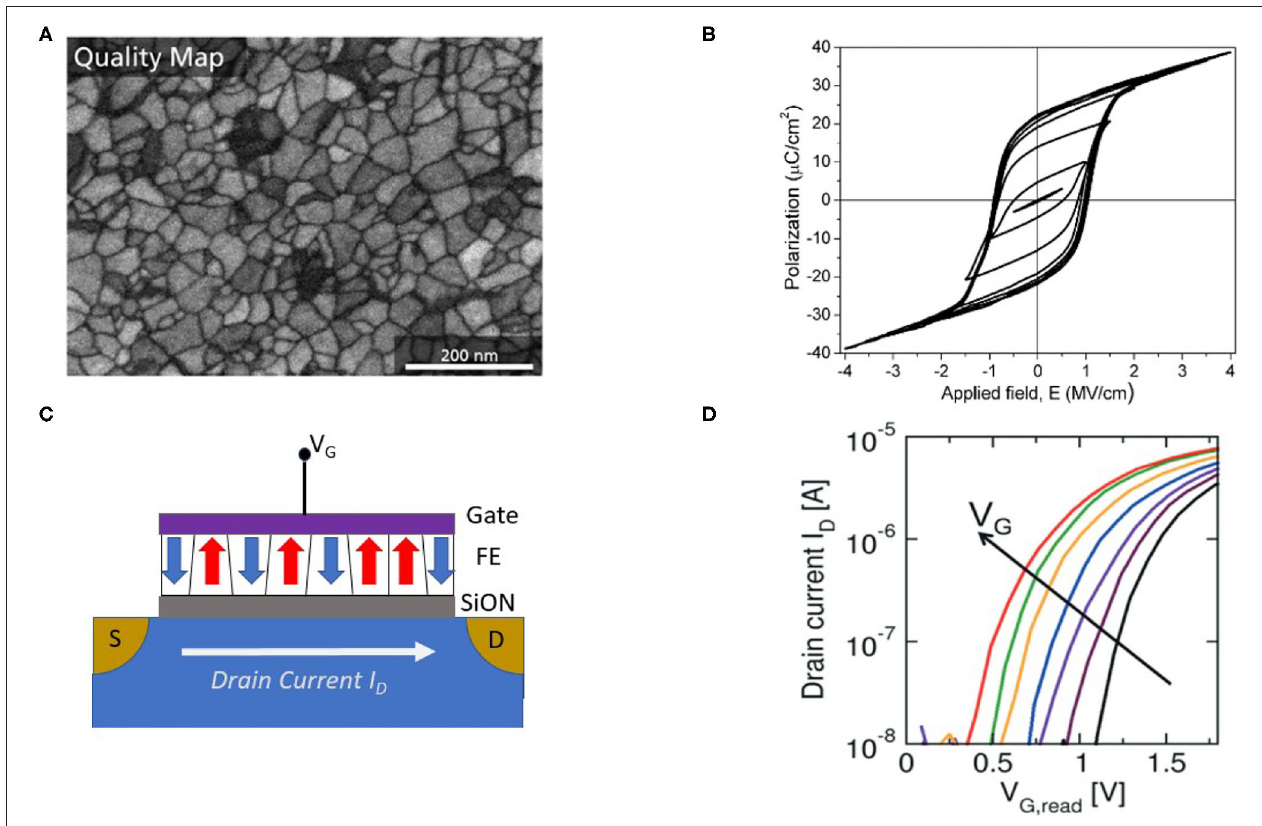
FIGURE 7 | (A) Image of polycrystalline multigranular HfZrO 2 thin film, where average grain size is around 30 nm. Figure reproduced with permission from Lederer et al. Appl. Phys. Lett. 115, 222902 (2019) Copyright 2019 AIP Publishing. (B) Polarization-electric field (P-E) loops with hysteresis of HfO 2 . Figure reproduced with permission from Zhou et al. Acta Mater. 99 (2015) 240–246. Copyright 2015 ELSEIVER. (C) Device structure of a FeFET. (D) Conductance states of FeFET modulated by the gate voltage. Figure reproduced with permission from Mulaosmanovic et al. (2017) Symposium on VLSI Technology (p. T176–T177) Copyright 2017